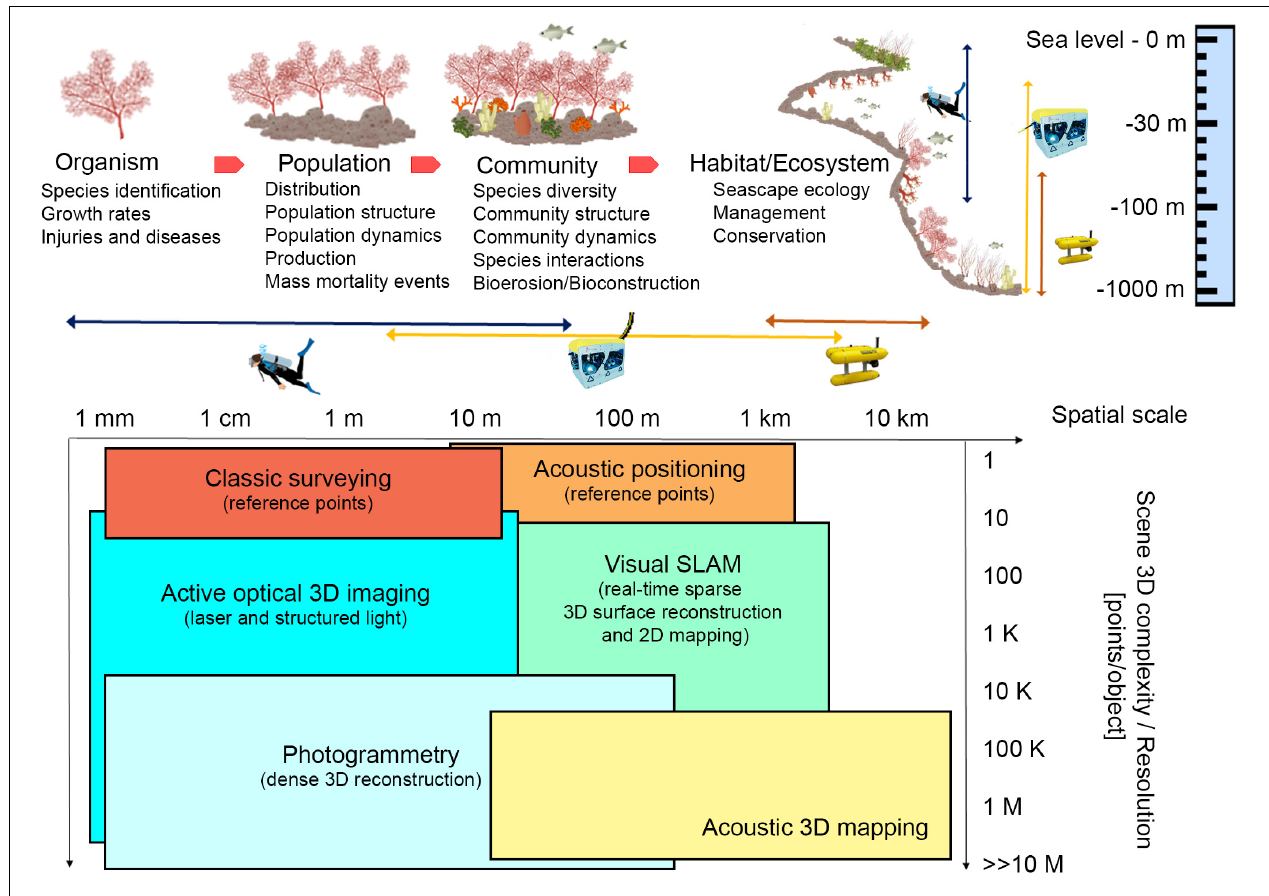
FIGURE 1 | Ecological key aspects of marine animal forests and different technological approaches that can be applied at different spatial scales, depth, and 3D complexity of investigated area. In the table at the bottom, SLAM stands for Simultaneous Localization And Mapping. Illustrations modified from Montero-Serra (2018), and NOAA. Source: IAN Symbols Library, University of